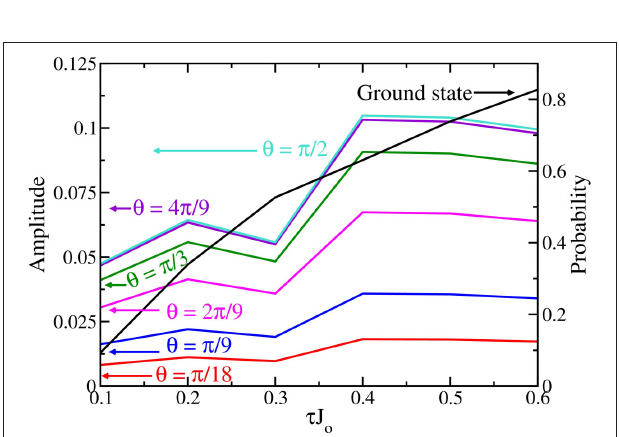
FIGURE 9 | Amplitude of the oscillations at B / J o = 0 as a function of different τ as compared to the ground state probability. The arrows for each curve point toward the appropriate vertical axis. As the θ increases, the amplitude of the oscillations increases as well. The amplitude of the oscillations become a maximum when the ground state probability is near 0.6 and the amplitude decreases when the ground state probability increases above or decreases below 0.6 . When τ = 0.3 there is a local minimum in the amplitude.